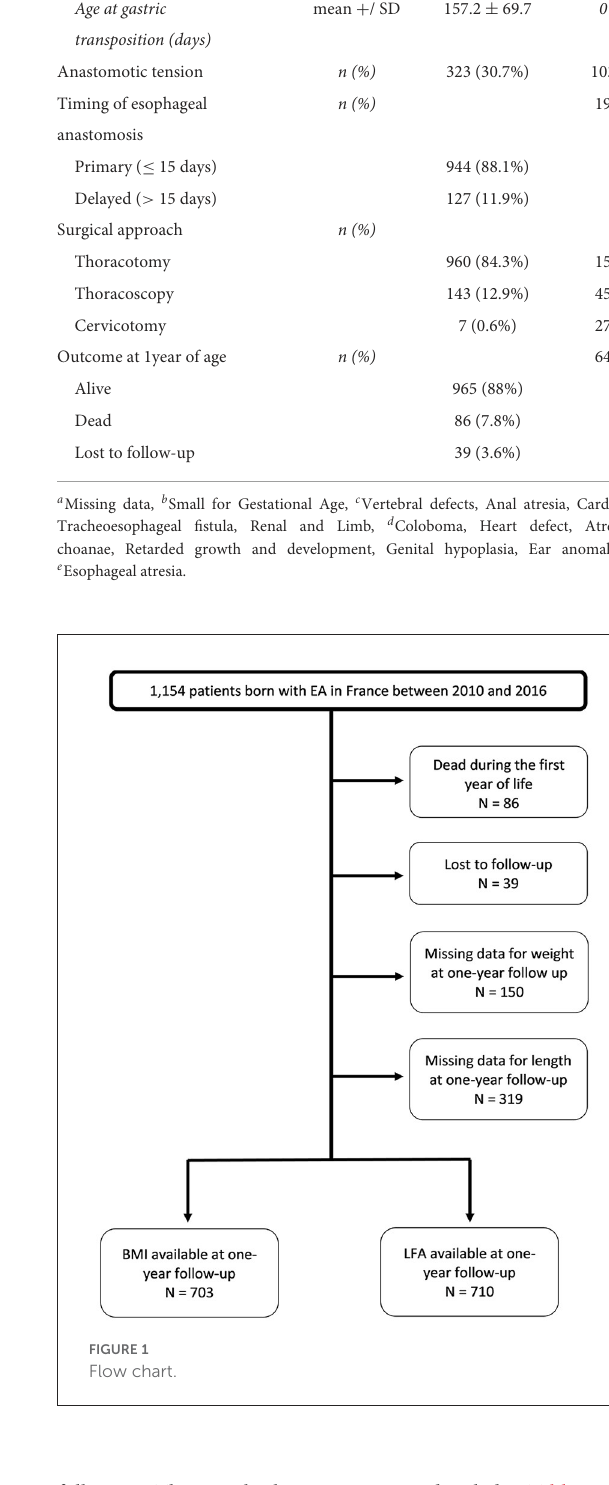
follow-up. The sample characteristics are detailed in Table 1